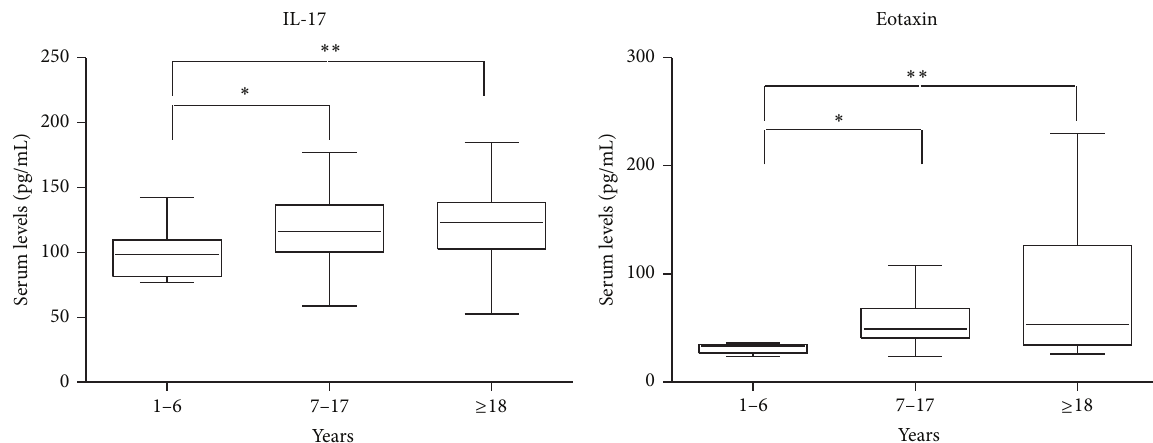
Figure 2: Box plots of serum levels (pg/mL) of cytokines IL-17 and Eotaxin for young children (1–6), children (7–17), and adults ( ≥ 18). Whiskers calculated adopting the Tukey method. Outliers not shown. ∗ 𝑃 < 0.05 , ∗∗ 𝑃 < 0.01 : Kruskal-Wallis test followed by Dunn’s multiple comparison